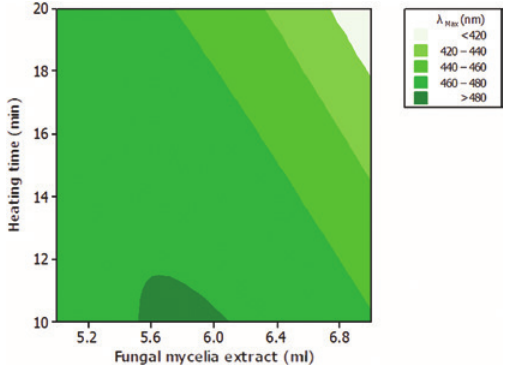
of the synthesized AgNP solution as Figure 3: Contour plot for λ max function of the A. fumigatus mycelia extract and heating